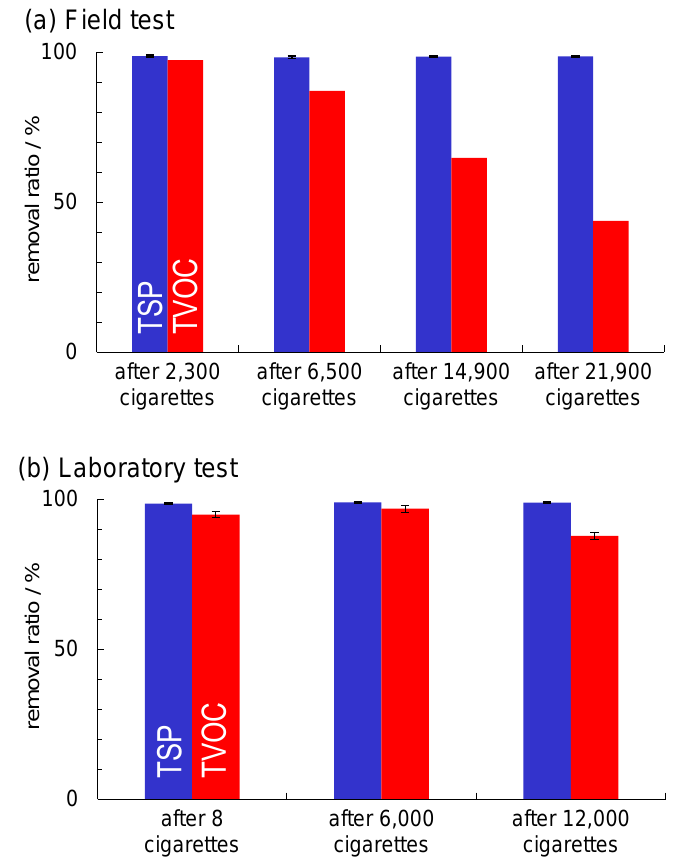
and CO removal in the field are being tested. Figure 7. Removal ratios of TSPs (blue) and TVOCs (red) in tobacco smoke by the air-cleaner ( a ) in the field and ( b ) in laboratory tests. Panel (b) is reproduced from